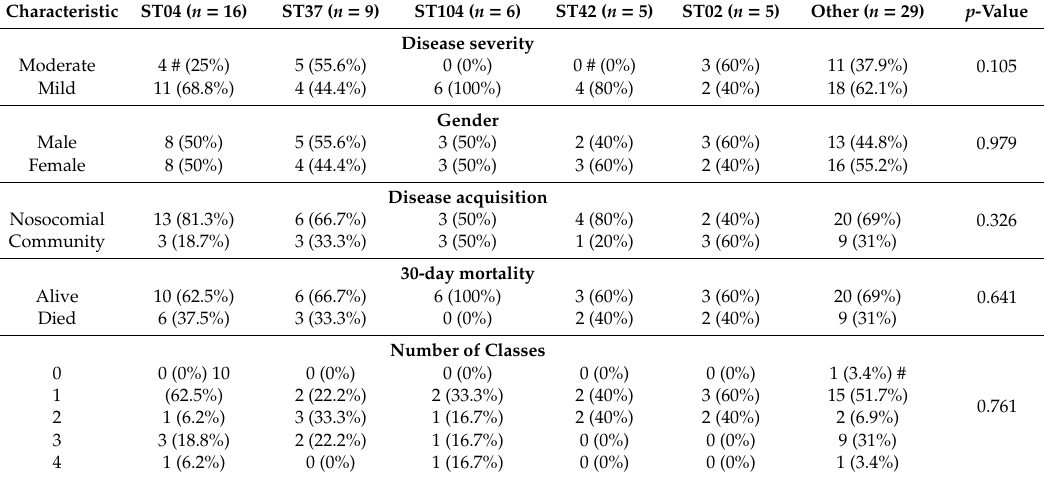
Figure 1. The prevalence of clades and sequence typing (STs) in the study. ( a ) Prevalence of the di ff erent clades. ( b ) The prevalence of the di ff erent STs in clade 2. ( c ) The prevalence of the di ff erent STs in clade 4. ( d ) The prevalence of the di ff erent STs in the study. Table 3. Associations between ST and epidemiological data .